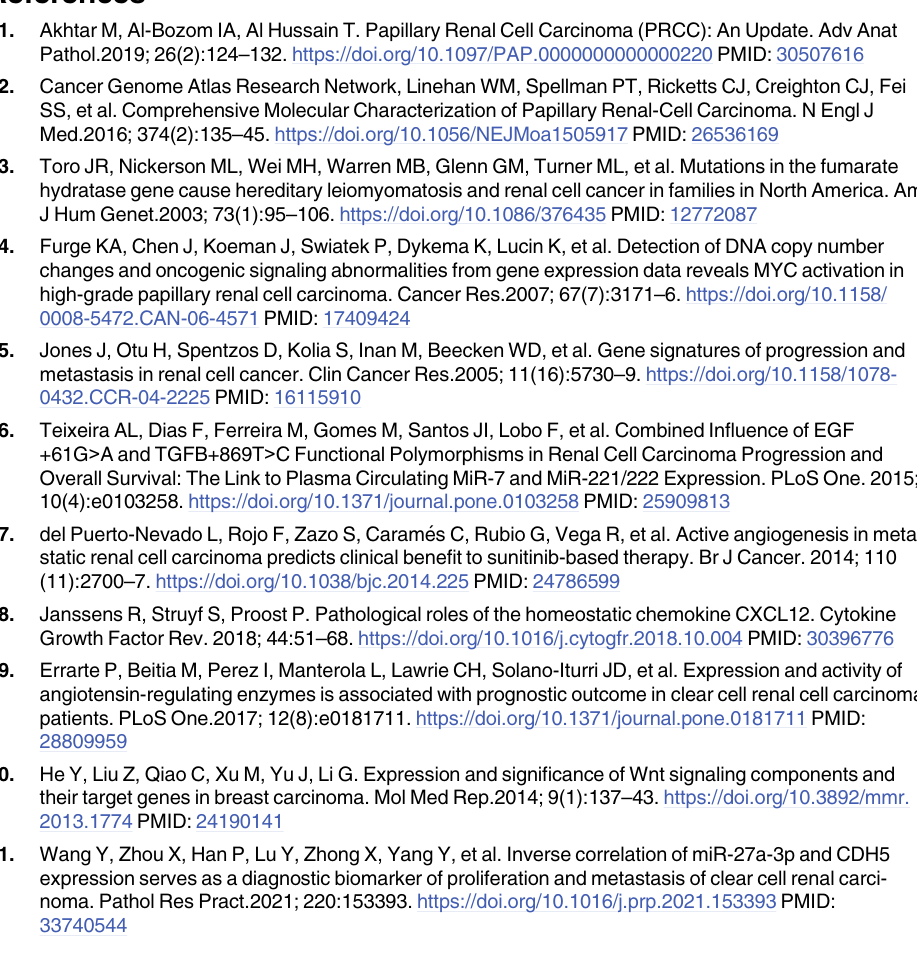
FC (fold change) 2